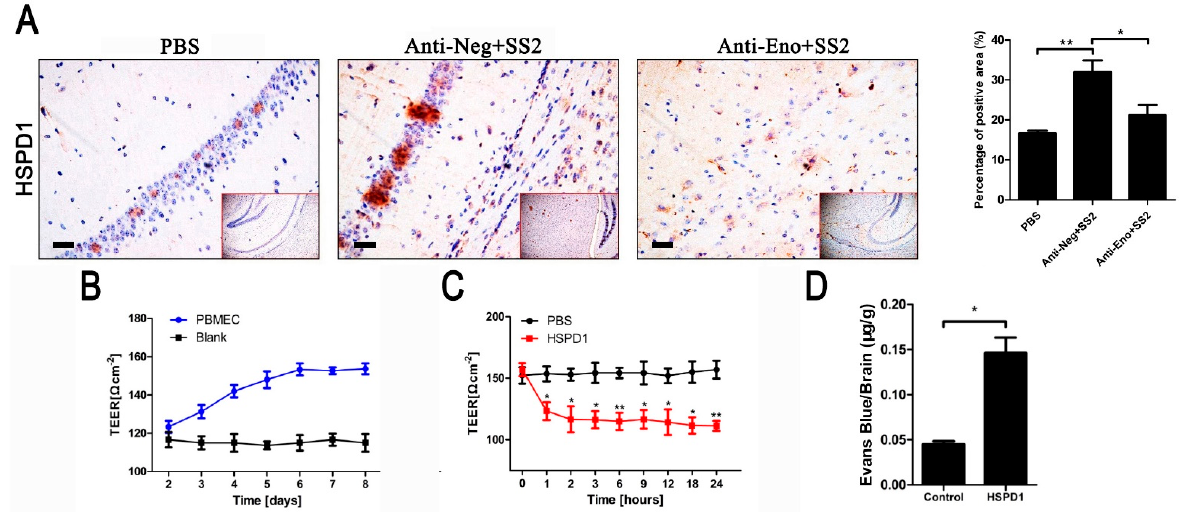
Figure 1. S. suis serovar 2 infection promotes the expression of HSPD1 which disrupts BBB in vivo and in vitro . ( A ) Immunohistochemical analysis of the mouse brain tissues from PBS, Anti-Neg+SS2, and Anti-Eno+SS2 groups (scale bar, 100 µm). ( B ) BBB model’s TEER changes. The Blank group equals the empty trans-well without cells. ( C ) BBB model’s TEER changes with or without HSPD1 treatment. ( D ) EB content of mouse brain tissues after HSPD1 treatment or in the untreated control group. ( S. suis serovar 2, SS2: Streptococcus suis serovar 2; HSPD1: heat shock protein family D member 1; BBB: blood–brain barrier; PBS: phosphate-buffered saline; TEER: trans-endothelial cell electric resistance; EB: Evans blue.) (*, p < 0.05; **, p <